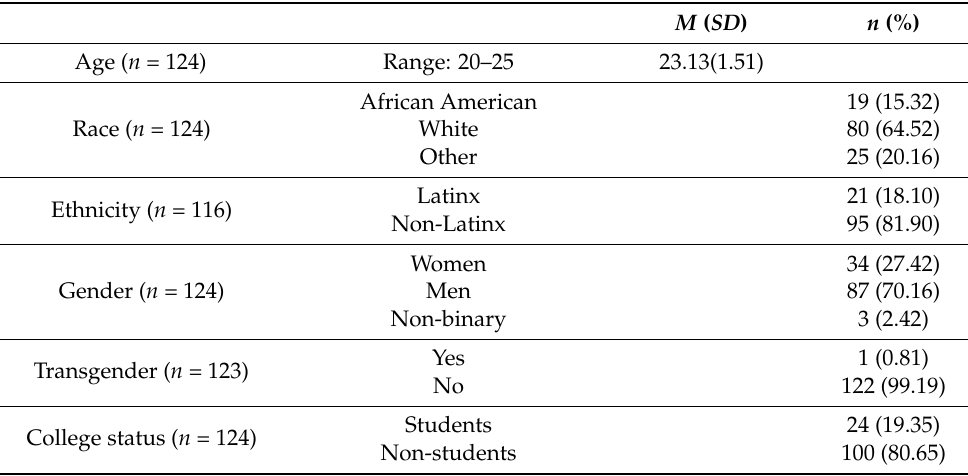
Table 1. Demographics and sample characteristics (Total N =